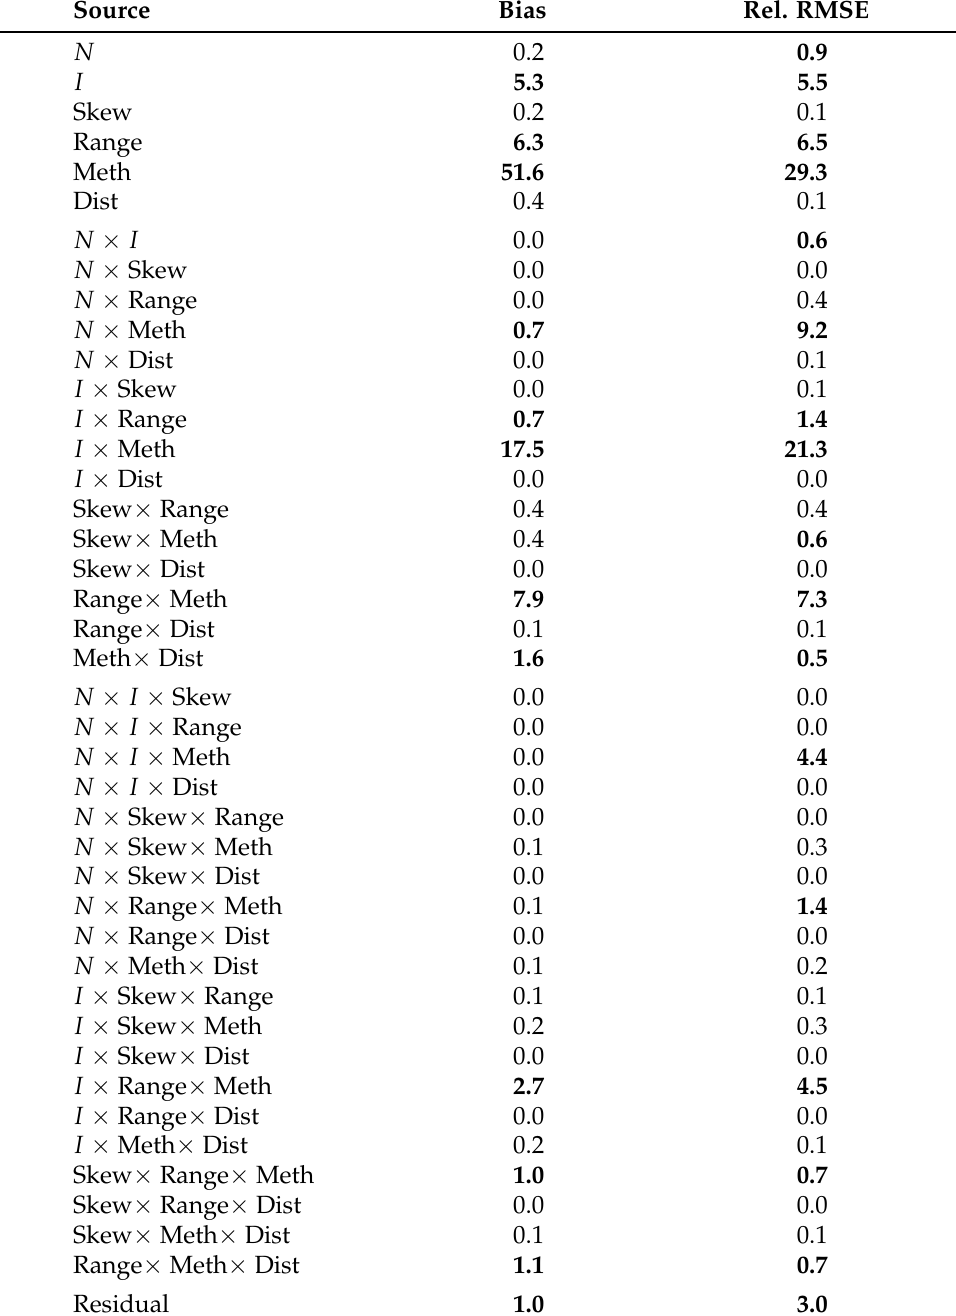
Table 1. Variance proportions of different factors in the simulation study for (mean absolute) bias and relative